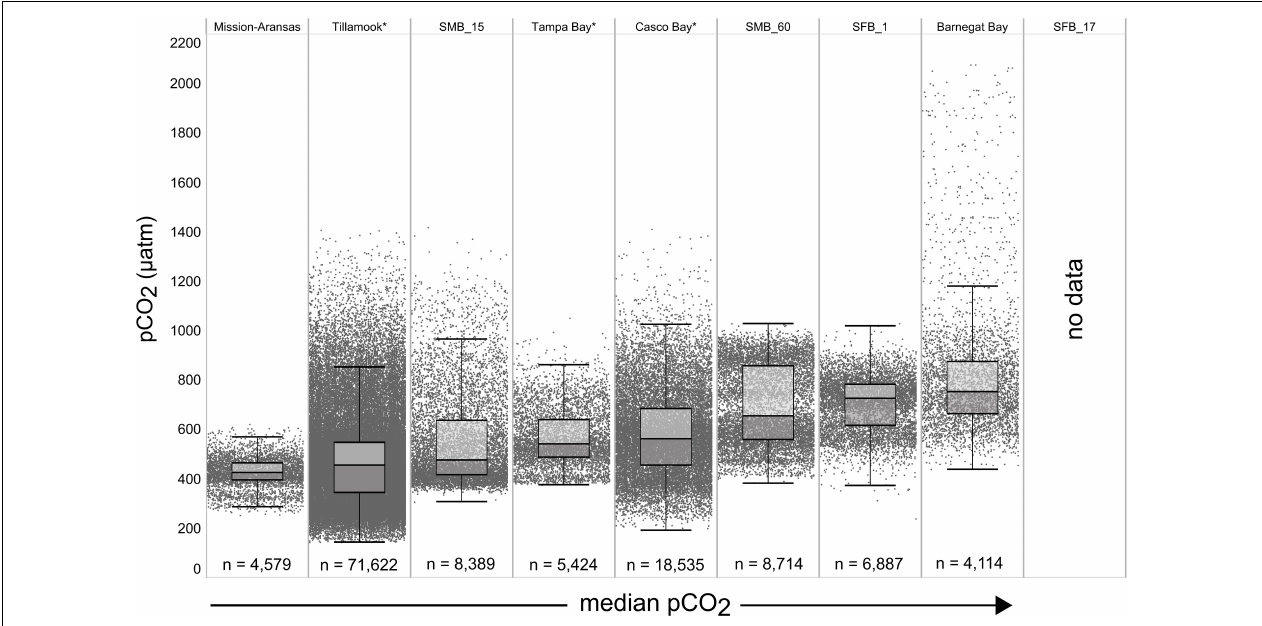
FIGURE 4 | Box plots and underlying data showing the distribution of partial pressure of carbon dioxide ( p CO 2 ) data across the seven water bodies. The water bodies are arranged from lowest median p CO 2 (Mission-Aransas Estuary) to highest median p CO 2 (Barnegat Bay) as calculated from all available data. Whiskers extend to data within 1.5 times the interquartile range (IQR), * = multi-year records. SMB_15 = Santa Monica Bay (15 m deployment); SMB_60 = Santa Monica Bay (60 m deployment); SFB_1 = San Francisco Bay (1 m deployment). p CO 2 data are not available for San Francisco Bay’s 17 m